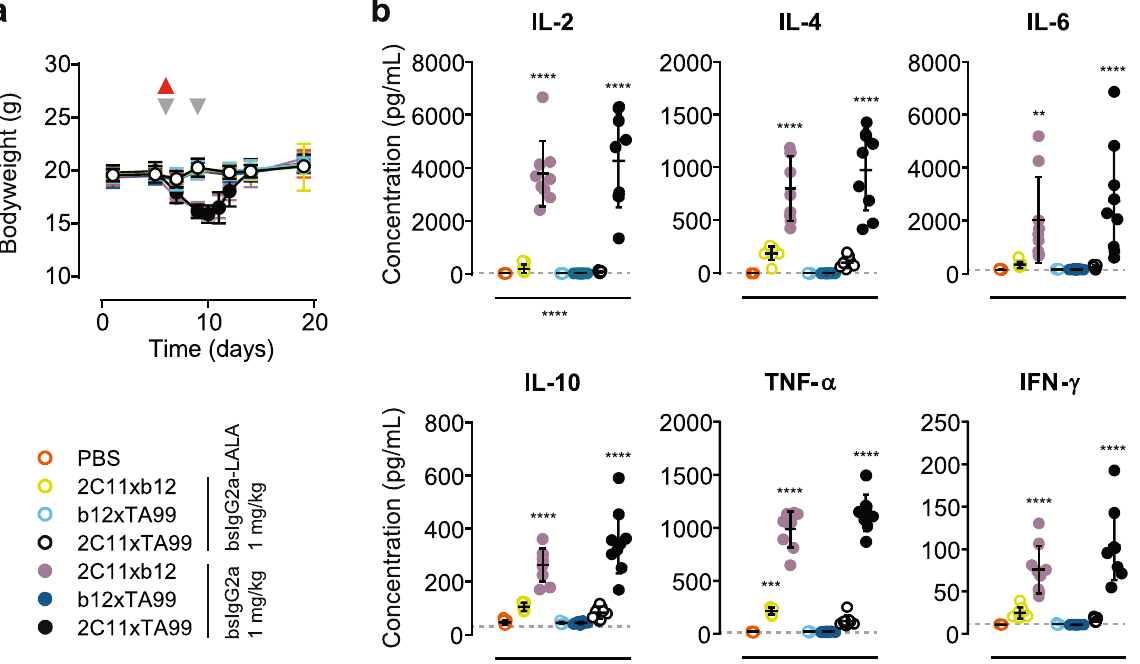
Figure 7. Evaluation of in vivo toxicity in a syngeneic B16-F10 xenograft model. Mice were dosed as described in Fig. 6B with the indicated bsAb variants. ( a ) Bodyweight followed over time (grey arrowheads indicate treatment days; red arrowhead indicates blood sampling). Data represent mean bodyweight ± SEM. ( b ) Cytokine concentrations at 1–2 h after the first dose. Data represent individual mice & mean ± SD. Statistical significance (compared to PBS control group) was determined by one-way ANOVA ( ** P < 0.01; *** P < 0.001; **** P <